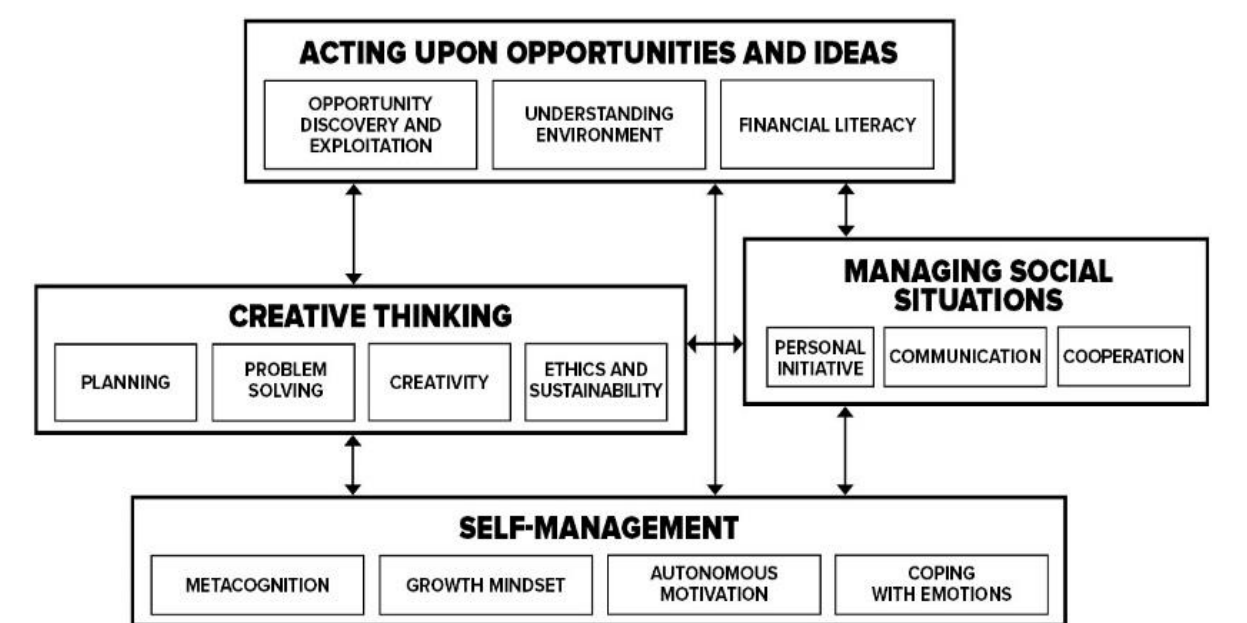
Figure 1. The proposed hierarchical-integrative structure of the entrepreneurship competence model describing reciprocal relations between sub-competencies. Source: created by the